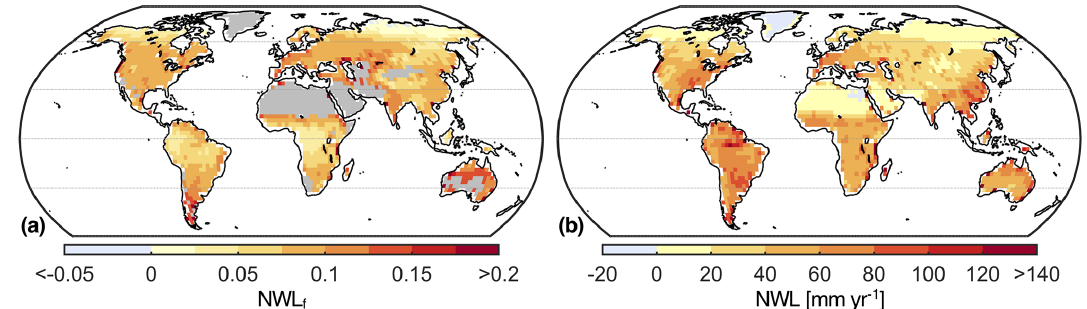
Figure 5. Map of multi-model mean NWL f (a) and NWL (b) on average over the period from 1976 to 2005. Desert regions and Greenland are masked in panel (a) due to division by small